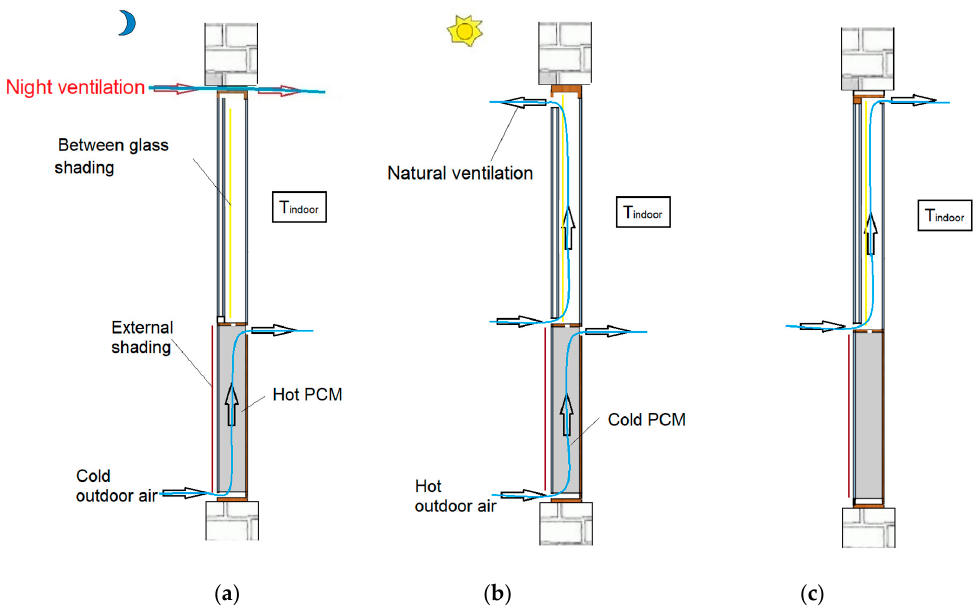
Figure 3. The working principle of the PCM ventilated window during summer [14]. ( a ) PCM discharge mode, when (hour < 7) or (hour > 20:00). ( b ) Ventilation pre-cooling mode, when T indoor > 24 °C . ( c ) Heat mode, when T indoor < 24 °C